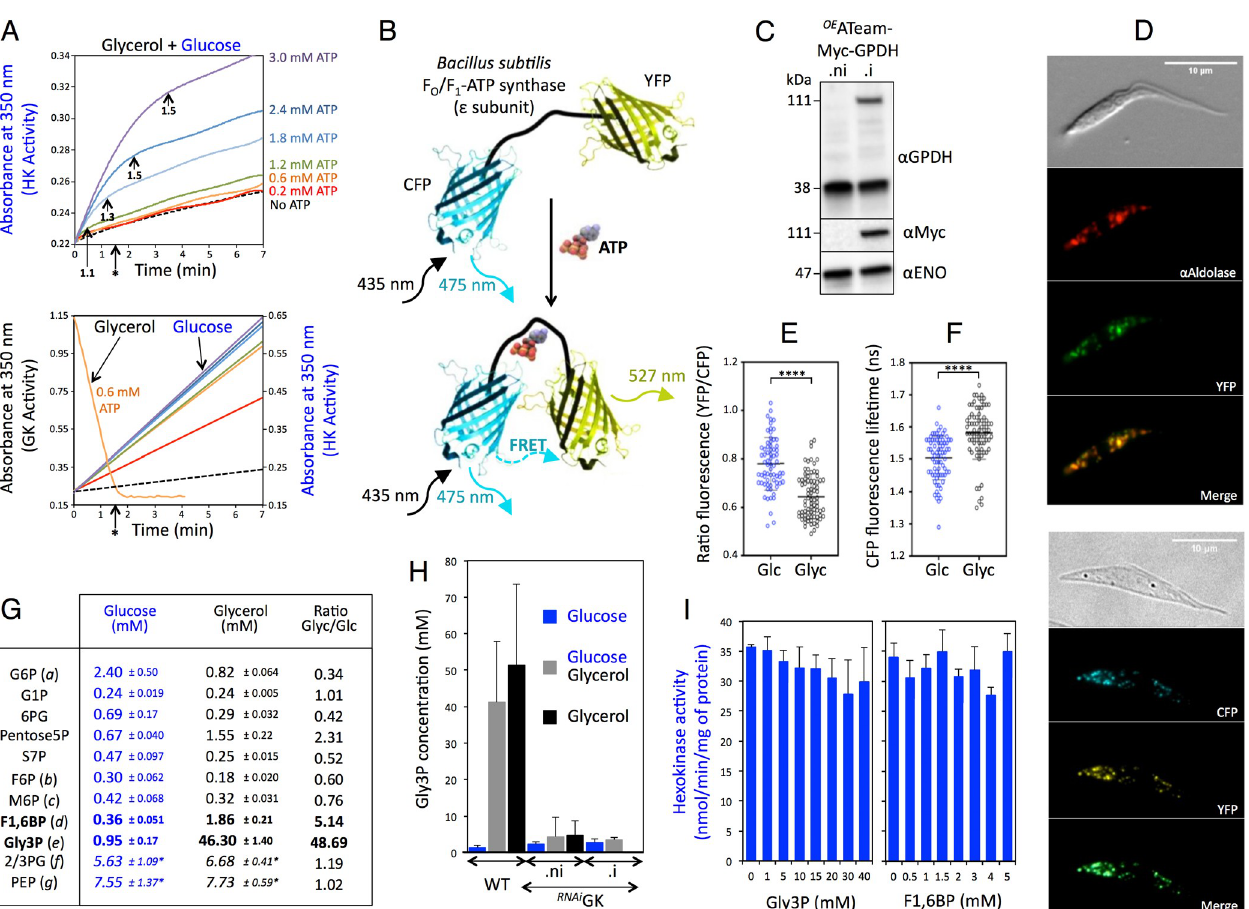
Fig 4. Analysis of intracellular ATP and metabolites. (A) The top panel shows hexokinase (HK) activity determined at 350 nm (NADPH production) over the incubation time of trypanosome extracts in the presence of 10 mM glucose and 10 mM glycerol and 0.2 to 3.0 mM ATP. The dashed lane corresponds to background HK activity measured without ATP. The arrows indicate the calculated ATP amounts (mM) remaining in the assay at the time of HK activity inhibition, taking into account glycerol kinase (GK) and HK activity. The asterisk indicates the time when 0.6 mM ATP is consumed by GK (deduced from the bottom panel). The bottom panel shows NADH consumption (GK activity) and NADPH production (HK activity) in the presence of 0.6 mM ATP (GK activity) or 0.2 to 3.0 mM ATP (HK activity). The dashed lane corresponds to HK activity measured without ATP. (B) Schematic drawing of the ATeam probe from [24]. Variants of cyan fluorescent protein (CFP; mseCFP) and yellow fluorescent protein (YFP; cp173-mVenus) were connected by the ε subunit of Bacillus subtilis F o F 1 -ATP synthase. In the ATP-free form (top), extended and flexible conformations of the ε subunit separate the 2 fluorescent proteins, resulting in a low fluorescence resonance energy transfer (FRET) efficiency. In the ATP-bound form, the ε subunit retracts to draw the 2 fluorescent proteins close to each other, which increases FRET efficiency. (C) The expression of ATeam-Myc-GPDH was controlled by Western blotting on total cell extracts of tetracycline-induced (.i) and uninduced (.ni) OE ATeam-Myc-GPDH cells using anti-GPDH ( α GPDH) and anti-Myc ( α Myc) immune sera, and as control anti-enolase ( α ENO) immune serum. (D) The subcellular localization of ATeam-Myc-GPDH was confirmed by immunofluorescence assays on the OE ATeam-Myc-GPDH.i cell line using an anti-aldolase immune serum as a glycosomal marker (top panel; the yellow YFP signal was converted to green to merge it with the red fluorescence corresponding to aldolase) or by observing the fluorescence activity of CFP and YFP (FRET) (bottom panel). (E) The ratio of YFP emission (FRET) and CFP emission after excitation at 435 nm in the OE ATeam-Myc-GPDH.i cell line incubated in the presence of glucose (Glc) or glycerol (Glyc) (mean ± SD, n = 2 independent experiments, ���� p < 0.0001). (F) The CFP fluorescence lifetime of the same cell line incubated in the same conditions (mean ± SD, n = 3 independent experiments, ���� p < 0.0001). (G) Intracellular concentrations of metabolites in procyclic form trypanosomes grown in the presence of 10 mM glucose or glycerol (letters in parentheses refer to Fig 1A). The concentrations of the 2 last metabolites (asterisk) cannot be calculated, and the ratio between the 12 C (sample metabolite) and 13 C (standard) area was considered. G6P, glucose 6-phosphate; G1P, glucose 1-phosphate; 6PG, 6-phosphogluconate; Pentose5P, pentose 5-phosphate (ribose 5-phosphate, xylulose 5-phosphate, and xylose 5-phosphate are not distinguished by ion chromatography high-resolution mass spectrometry); S7P, sedoheptulose 7-phosphate;M6P, mannose 6-phosphate; F6P, fructose 6-phosphate; F1,6BP, fructose 1,6-bisphosphate; Gly3P, glycerol 3-phosphate; 2/3PG, 2- or 3-phosphoglycerate; PEP, phosphoenolpyruvate. (H) Enzymatic determination of intracellular Gly3P concentration in the parental (wild-type [WT]), RNAi GK.ni and RNAi GK.i cell lines grown in 10 mM glucose (blue), 10 mM glycerol (black) or both (grey). The absence of detectable amounts of Gly3P in cellular extracts from the RNAi GK.i mutants maintained in glycerol (last column) is probably due to cell quiescence caused by the impossibility of this mutant to metabolize glycerol. The intracellular concentrations of metabolites are calculated with the assumption that the total cellular volume of 10 8 cells is equal to 5.8 μ L [27]. (I) Effect of increasing amounts of Gly3P and F1,6BP on HK activity determined in total extracts of procyclic form T . brucei . Data supporting the results described in this figure can be found at https://zenodo.org/record/5075637#.